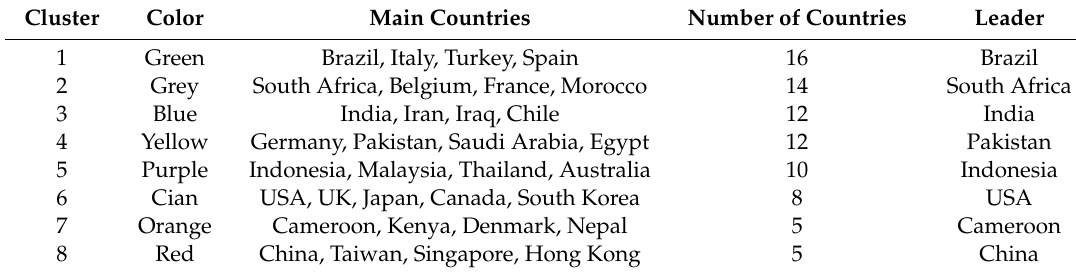
Figure 11. Countries network collaboration. Table 8. Countries collaboration in the period 2009 – 2019.